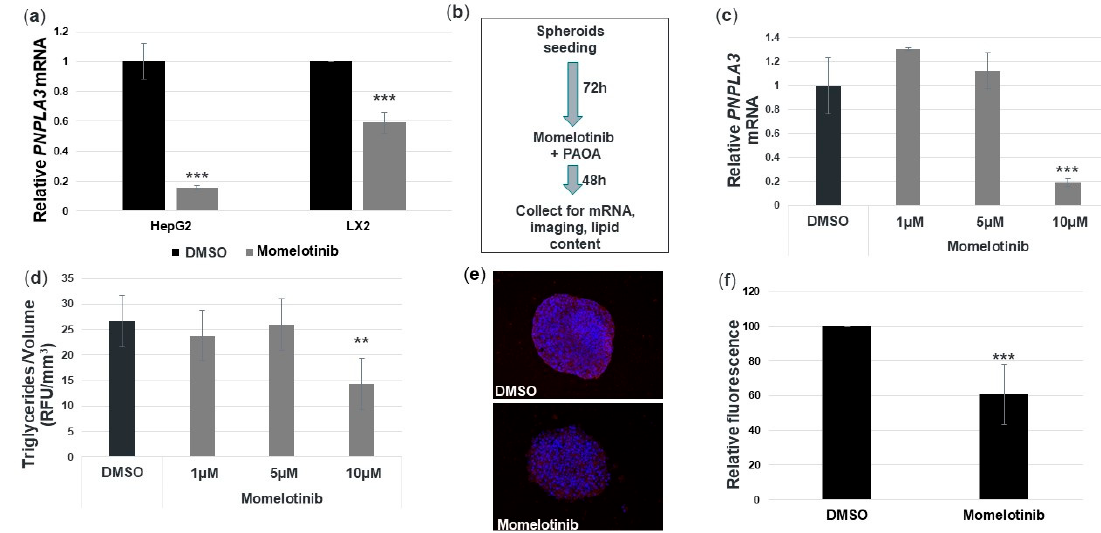
Figure 4. Momelotinib decreases PNPLA3 mRNA in a 3D non-alcoholic steatohepatitis (NASH) model, composed of spheroid cultures of HepG2 and LX-2 cells. ( a ) PNPLA3 mRNA is decreased in HepG2 and LX2 monolayer cultures after 18 h of treatment with 10 µ M momelotinib. The average and SD of three independent HepG2 experiments and six independent LX2 experiments are shown. An unpaired t -test indicates statistical significance ( p < 0.001). ( b ) Experimental overview of HepG2 / LX2 spheroid formation and compound treatment. After allowing spheroids to form for 72 h, they were supplemented with a palmitic acid–oleic acid mixture (PAOA) along with momelotinib. After another 48 h, they were collected for imaging and RNA analysis. ( c ) PNPLA3 mRNA levels after treatment of spheroids with momelotinib. The average of four independent experiments is shown with SD. An unpaired t -test shows a significant reduction with 10 µ M momelotinib versus DMSO ( p < 0.001). ( d ) Average triglyceride content after treatment with momelotinib, as assayed by relative fluorescence unit (RFU) and adjusted to the average spheroid volume (RFU / mm 3 ). Shown is the average of five independent experiments along with SD. An unpaired t -test was used to calculate significance of 10 µ M treatment relative to DMSO ( p < 0.01). ( e ) Representative images of spheroids stained with DAPI (blue) and ORO (red) after treatment with momelotinib. ( f ) The relative fluorescence (arbitrary units) was analyzed for three independent spheroids calculated as ORO stain per number of nuclei. An unpaired t -test ( a , f ) or one-way ANOVA ( c , d ) indicate statistical significance.** indicates p ≤ 0.01; *** indicates p ≤ 0.001.